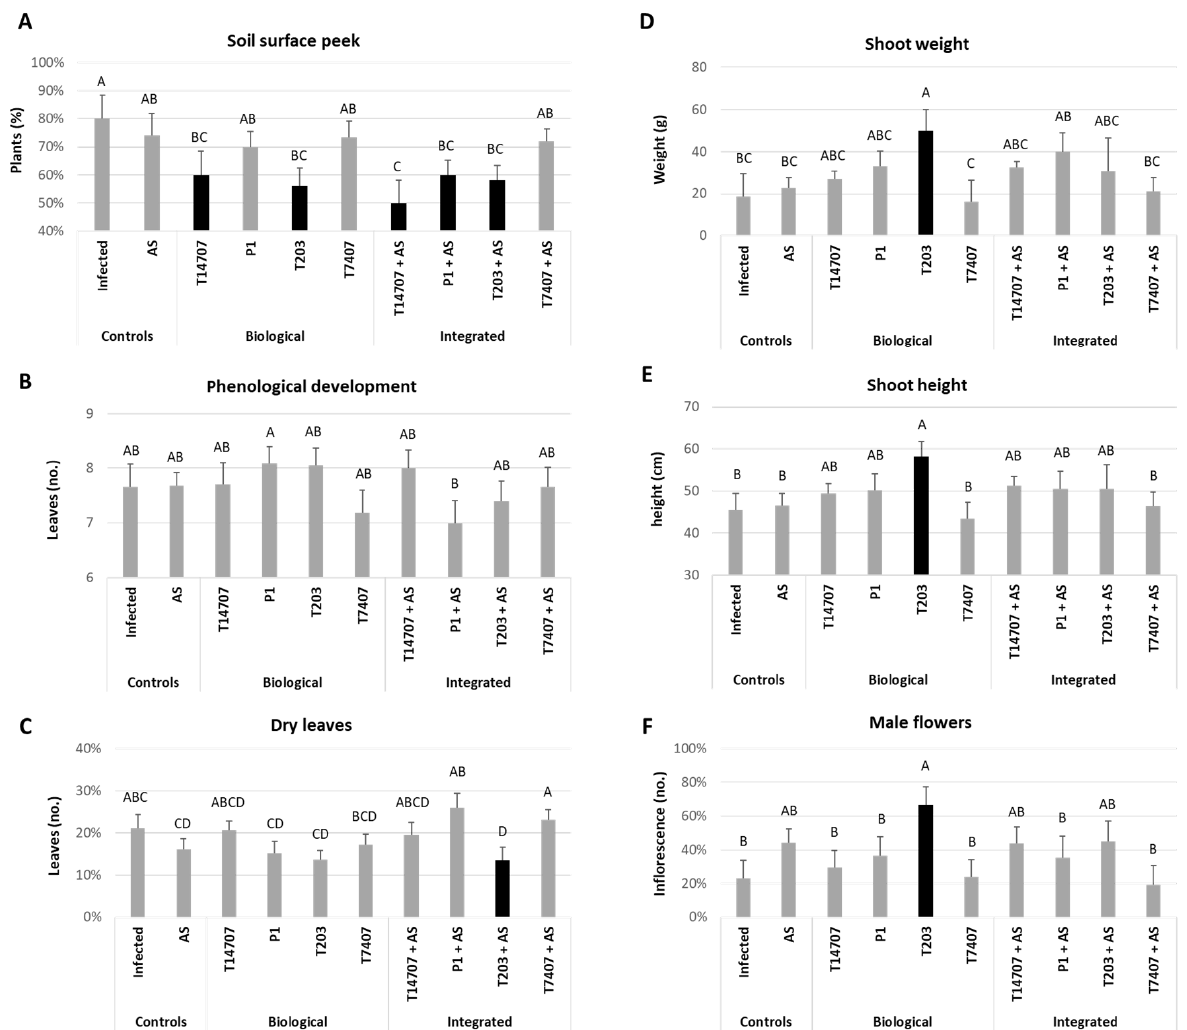
Figure 7. The open-enclosure trial above soil surface peek (emergence, day 9) and midseason sampling (day 40) growth evaluation. The experiment is described in Figure 6. The estimation included aboveground emergence percentages ( A ), phenological development of the plants (total number of leaves) ( B ), percentage of dry leaves ( C ), fresh weight of the shoot ( D ) and height ( E ), and percentage of plants with male flowers ( F ). The experiment was conducted in 16–26 repetitions (plants) per treatment. Error bars indicate standard error. Different letters above the chart’s bars (A–D) represent an ANOVA test significant difference ( p < 0.05).